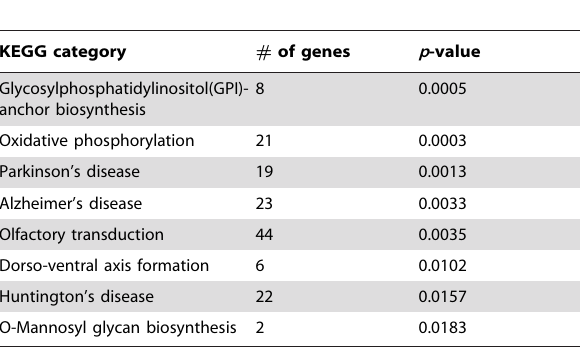
Table 5. Functional categories in KEGG that were significantly enriched in the genes associated with weight